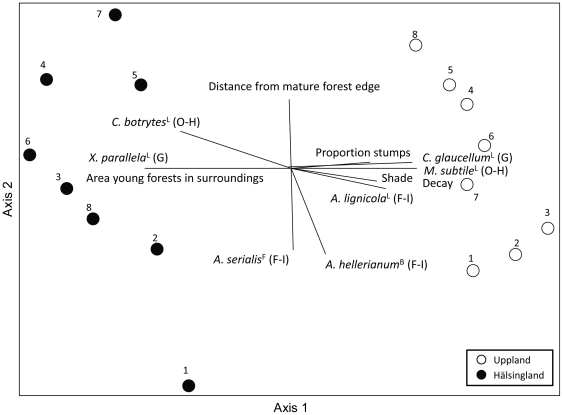
Epixylic cryptogam species composition in young stands along the distance from the mature stand.Non-metric multidimensional scaling (NMS) graph, where circles respresent transects (1–8) in Uppland (open) and Hälsingland (filled). Average values of individual species occupancy (arcsine squareroot transformed) in each transect number and each region were used in the calculations of ordination scores. Lines indicate the direction and strength (line length) of correlations (|r| ≥ 0.60) between ordination scores and explanatory variables (including transformed average occupancy values for individual species). L = lichen, B = bryophyte, F = fungus, O-H = open-habitat, F-I = forest-interior, G = generalist. Axis 1 and 2 explained 82 and 11% of the variance in the data, respectively.